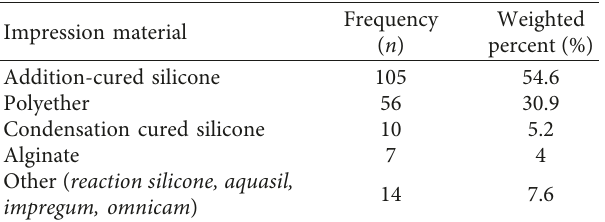
Table 3: Type of impression materials used by the dentists surveyed.